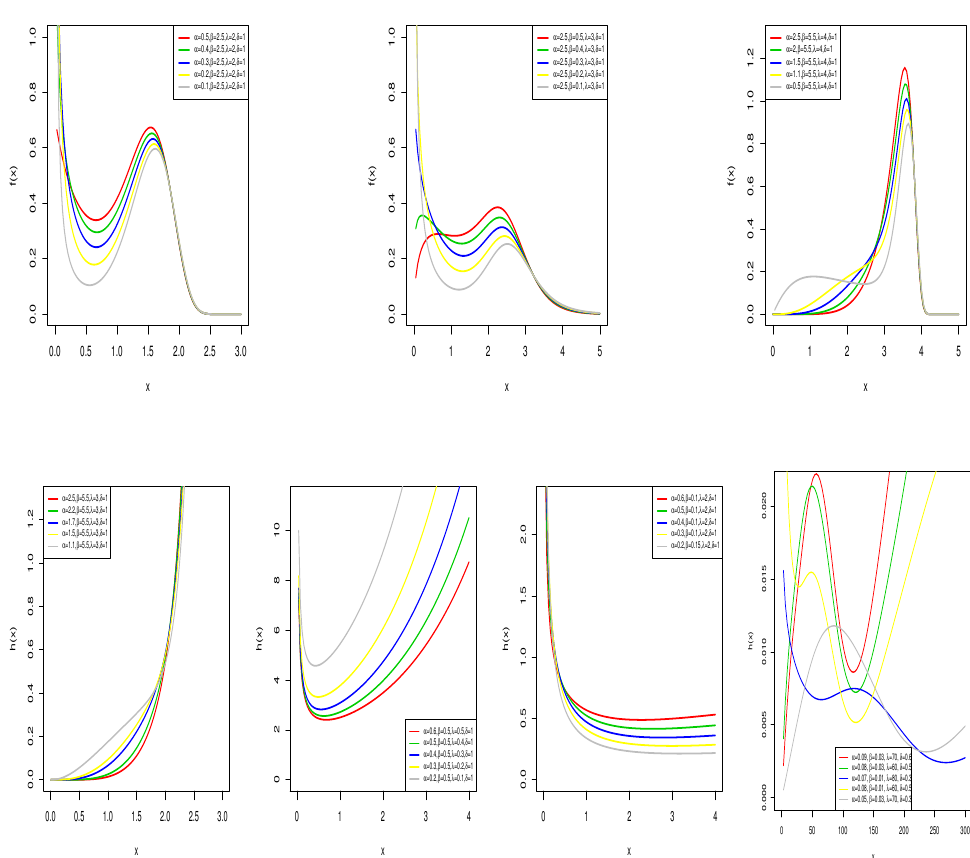
Figure 3. The pdf and hrf plots of the AOLLOW-Ga